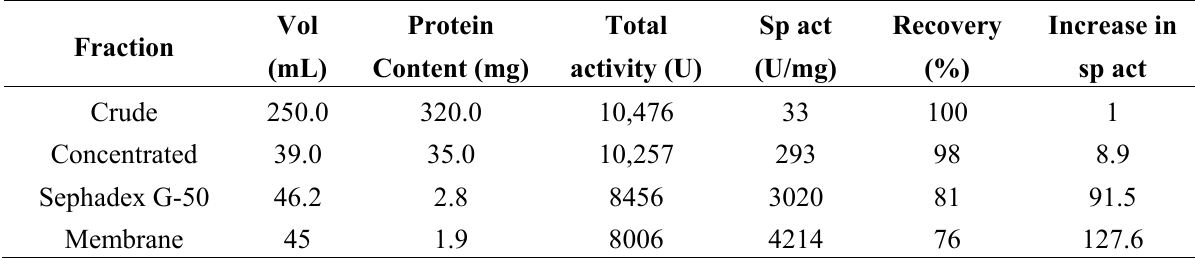
Table 1. Overall purification of the thermophilic RNase a